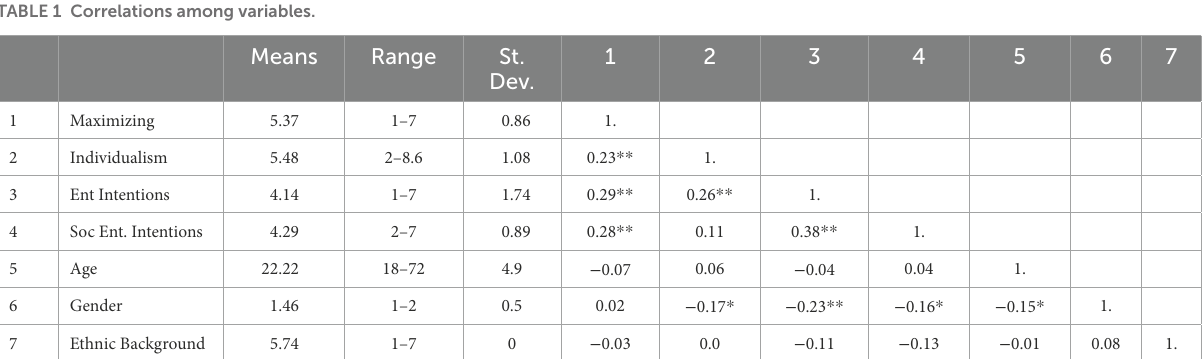
TABLE 1 Correlations among variables.